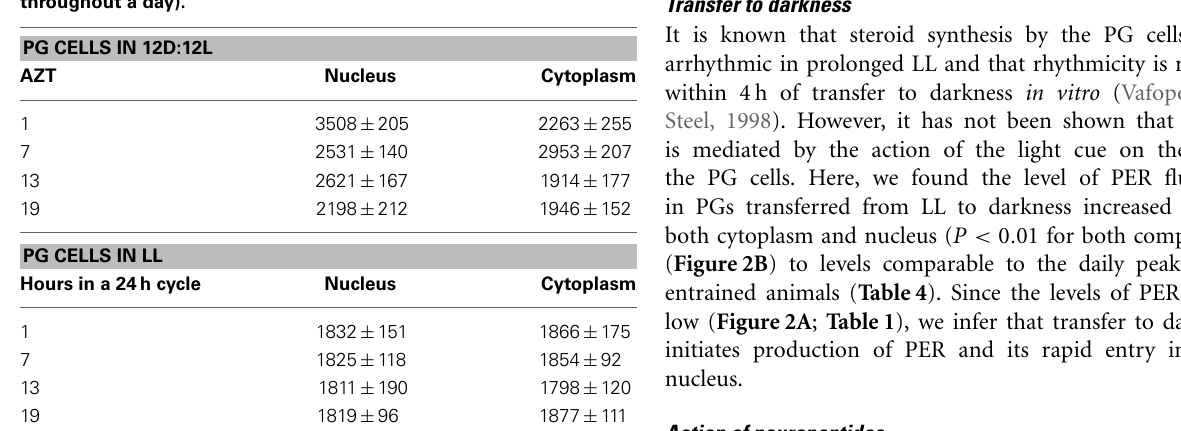
Table 1 | PG cells (mean relative PER fluorescence ± SEM every 6h throughout a day).